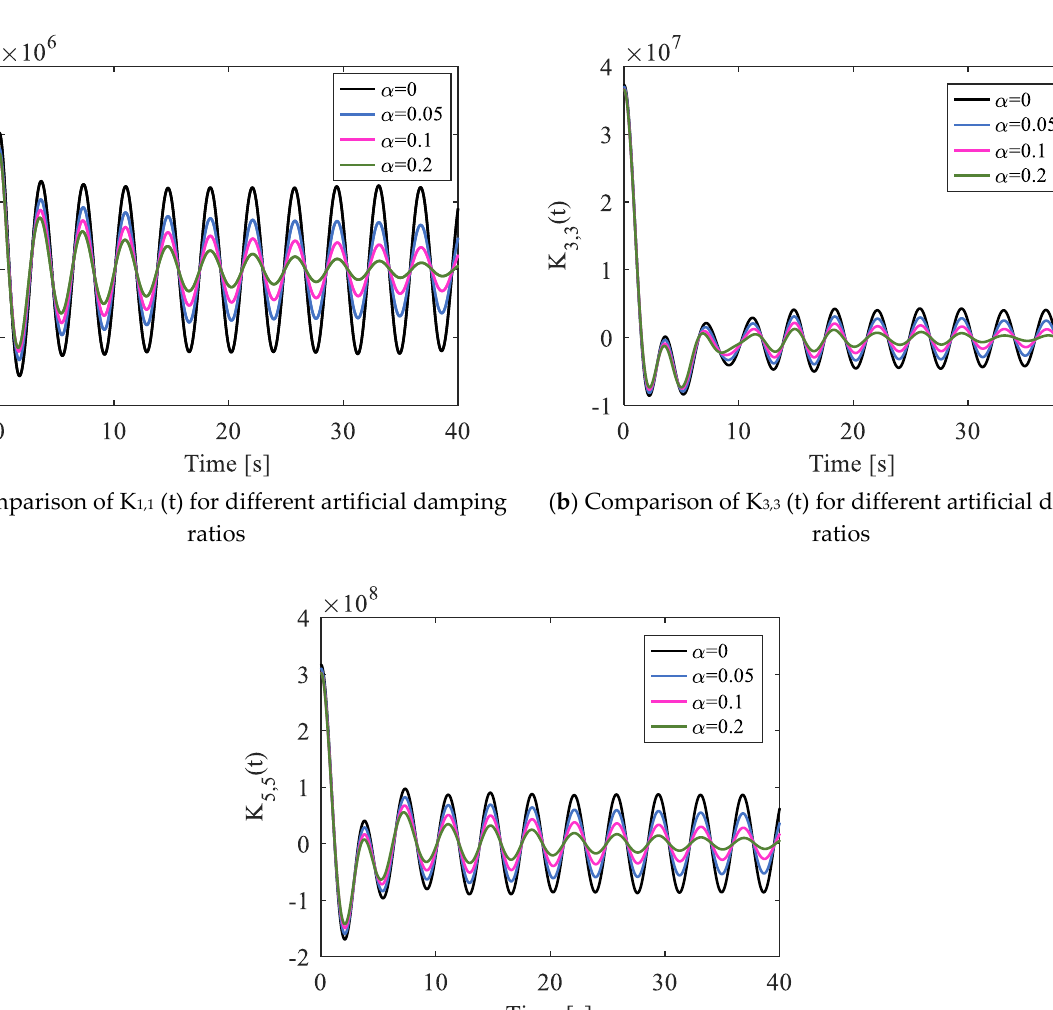
Figure 12. Comparison of the calculated impulse response function K(t) for the windward module with different module numbers.